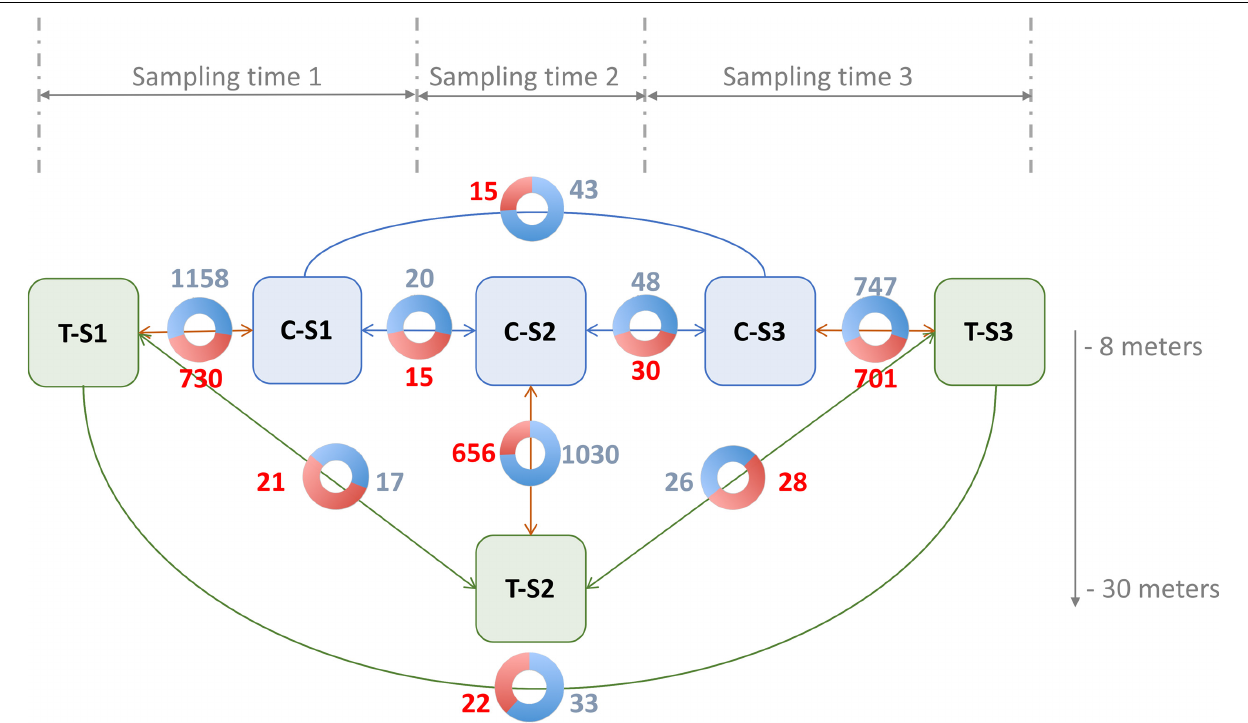
FIGURE 4 | Number of significant hypermethylated (in red) and hypomethylated (in blue) positions ( q < 0.05) in the nine pairwise comparisons. Blue boxes are the control groups, green boxes are the treatment groups. T, depth treatment individuals (in green); C, control individuals (in blue); S, sampling